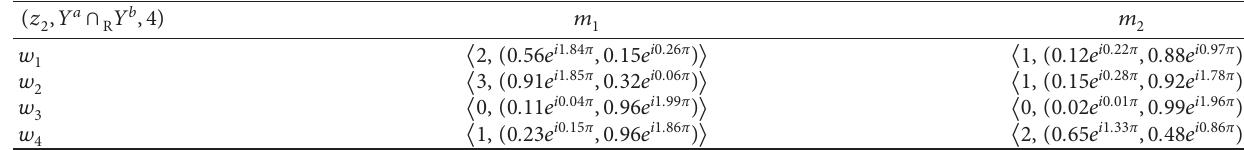
Table 12: Restricted intersection.